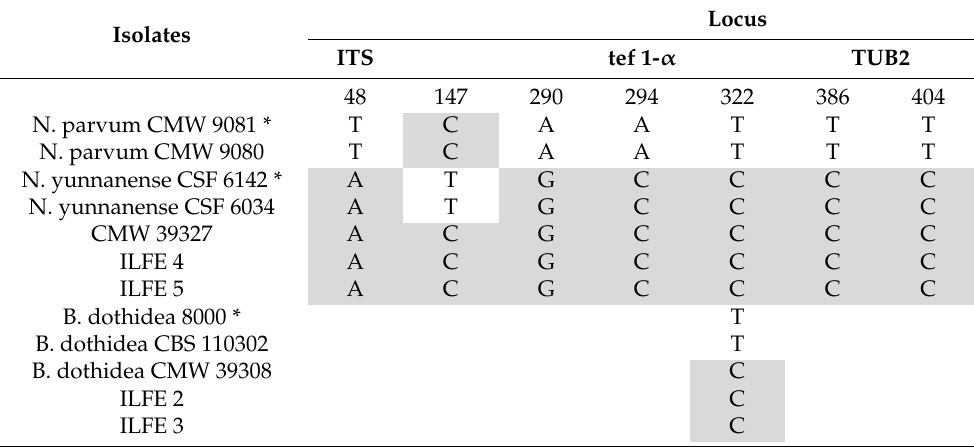
Table 2. Polymorphisms in the nucleotide sequences of ITS, tef 1- α and TUB2 loci between isolates ILFE 4, ILFE 5, CMW 39327, N. yunnanense , and N. parvum and between isolates ILFE 2, ILFE 3, and B. dothidea . The ex-type strains are marked with an asterisk and shared polymorphisms are highlighted in